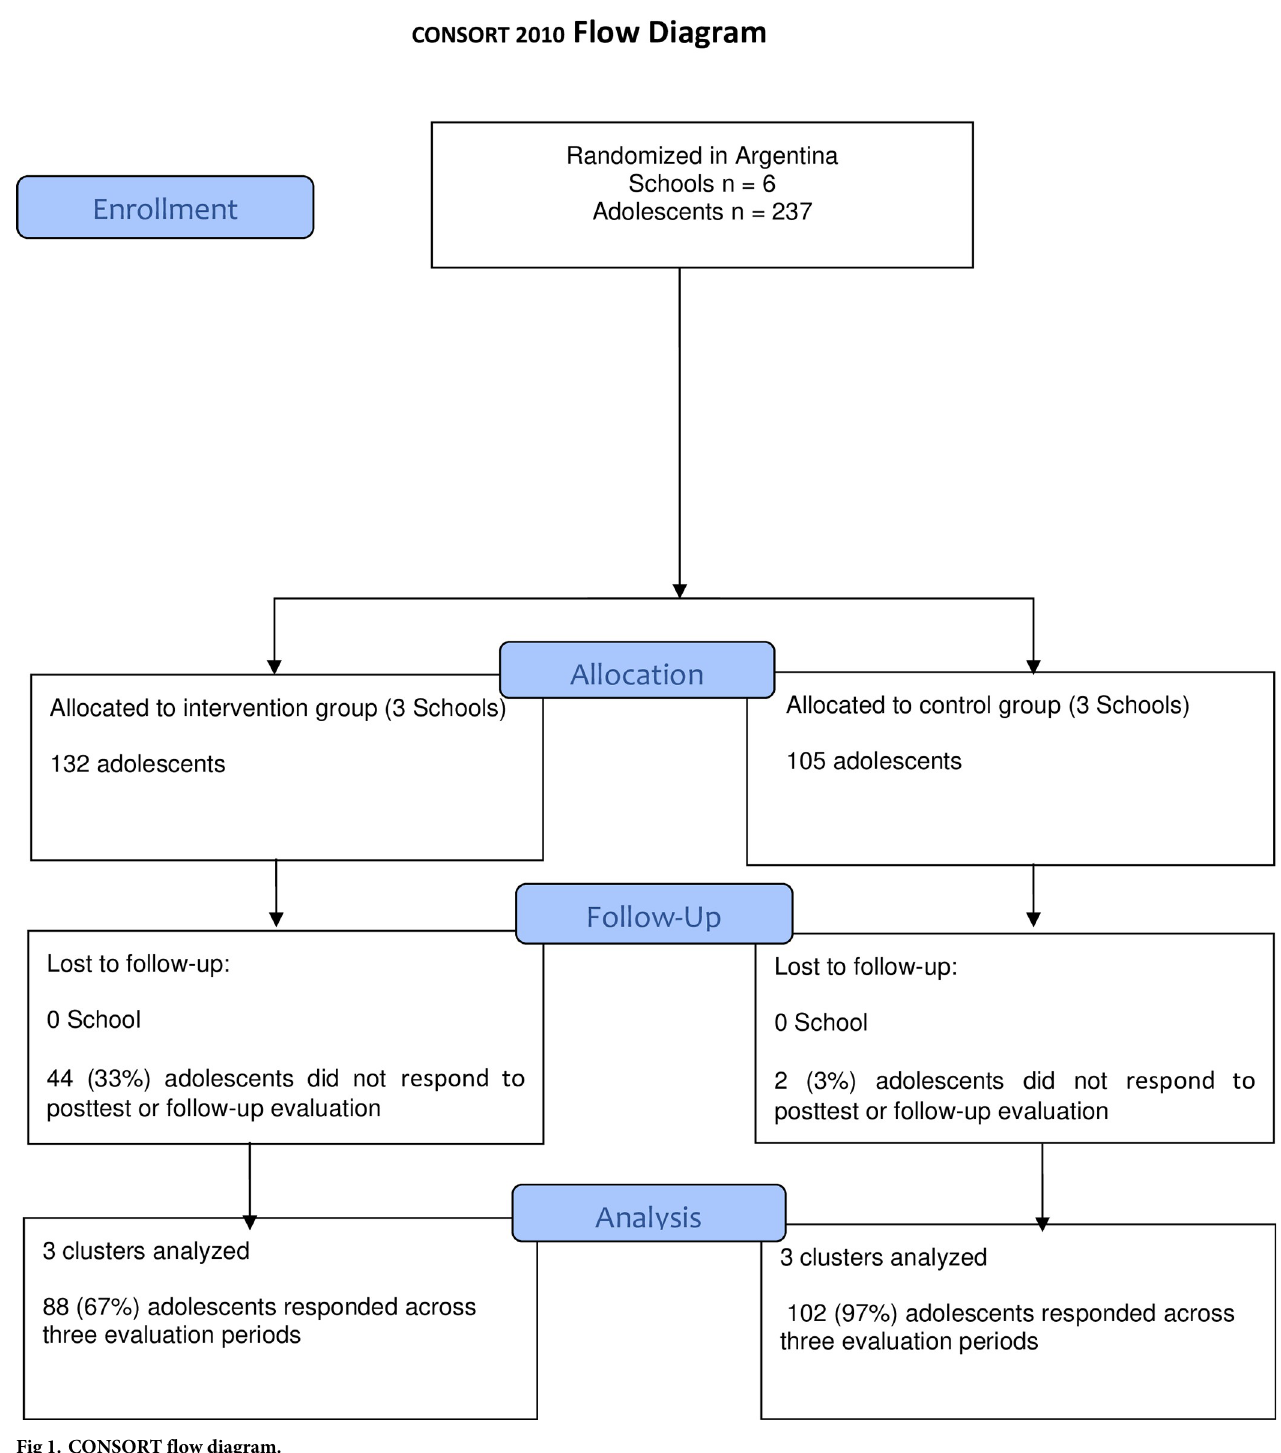
Fig 1. CONSORT flow diagram.